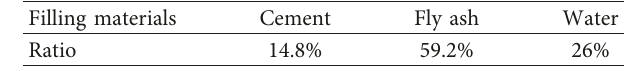
Table 1: Chemical contents of fly ash.